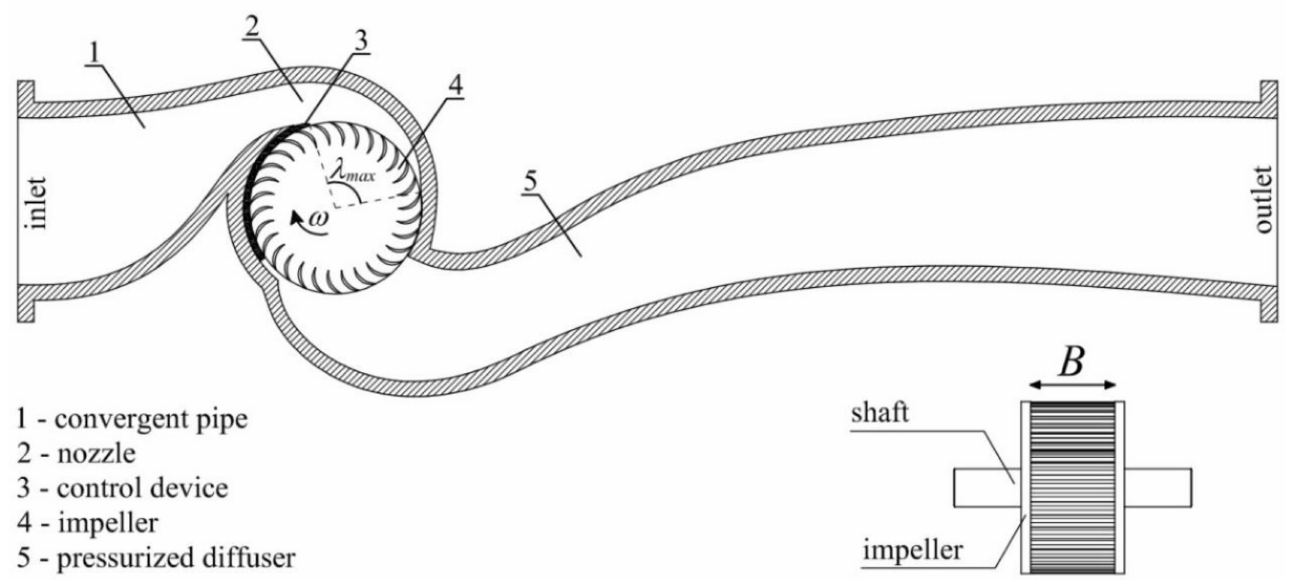
Figure 1. Power recovery system (PRS) turbine